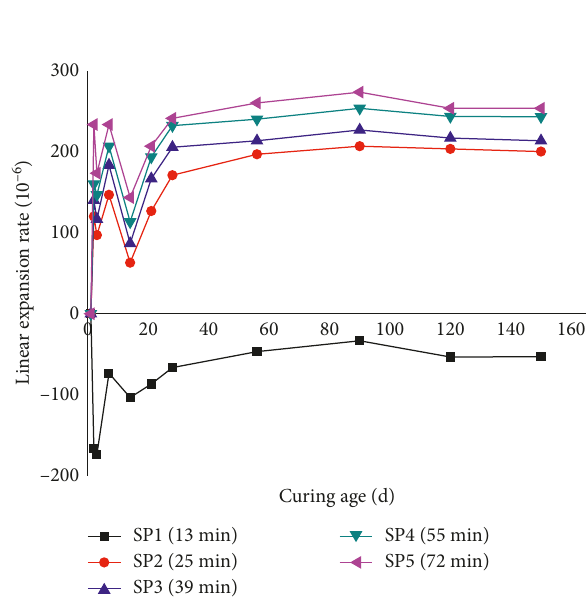
Figure 4: Linear expansion rate of the mortars with different grinding